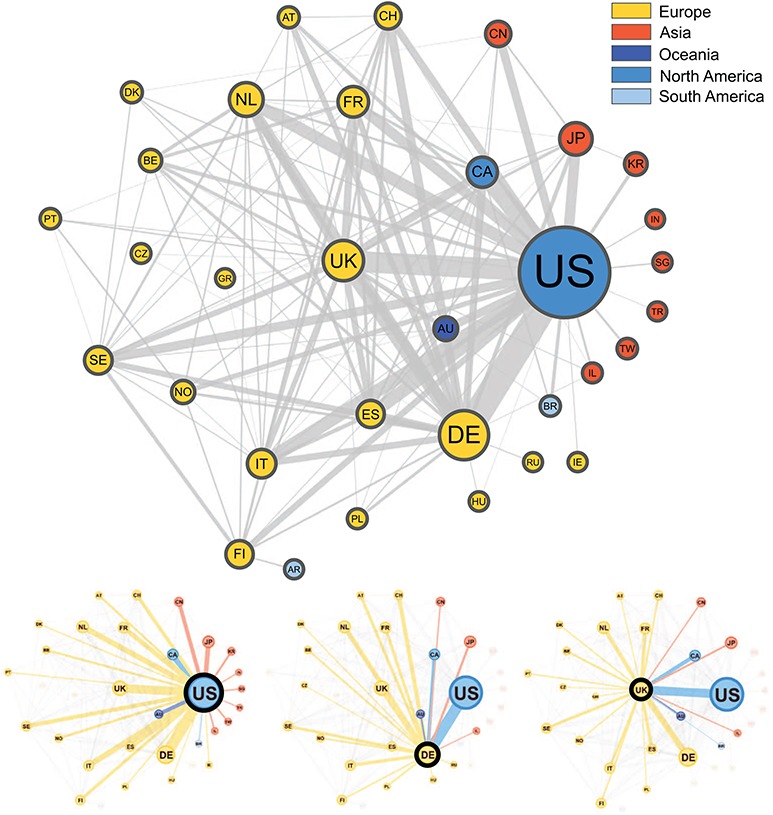
Graphical representation of the collaborations between countries based on 3093 publications contained in the Progenetix database. Collaborating countries for the three most frequent countries—the United States (US), Germany (DE) and the United Kingdom (UK)—are also shown in their own graphs. Node size is proportional to the country counts (linearly scaled between 10 and 50), node color represents the country’s continent and edge thickness is proportional to the collaboration counts. To reduce clutter in the graph, only countries appearing on more than seven publications appear in the graph, meaning our graph depicts \documentclass[12pt]{minimal}
\usepackage{amsmath}
\usepackage{wasysym}
\usepackage{amsfonts}
\usepackage{amssymb}
\usepackage{amsbsy}
\usepackage{upgreek}
\usepackage{mathrsfs}
\setlength{\oddsidemargin}{-69pt}
\begin{document}
}{}$\sim $\end{document}49% of all nodes and 29% of all edges in our data.